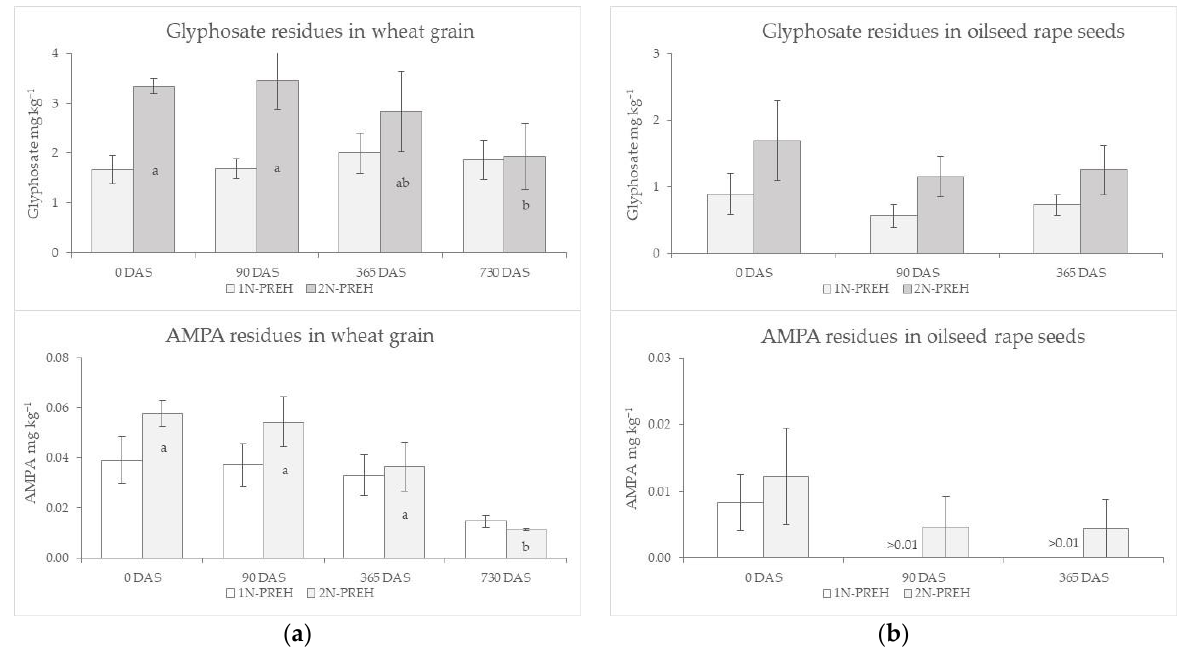
Figure 1. The influence of the pre-harvest application on glyphosate and AMPA residues after har- vesting, at 0, 90, 365 and 730 DAS (days after storage): ( a ) in spring wheat grain; ( b ) in spring oilseed rape seeds. The bars on the columns indicate standard errors ( n 3), lowercase letters within the same type of columns mean significant differences ( p < 0.05) for the glyphosate and AMPA residues dur- ing the storage.